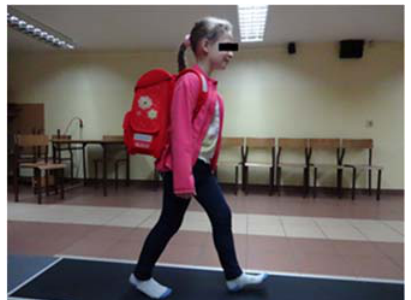
Figure 2. Measurement path including level adjustments and research environment.